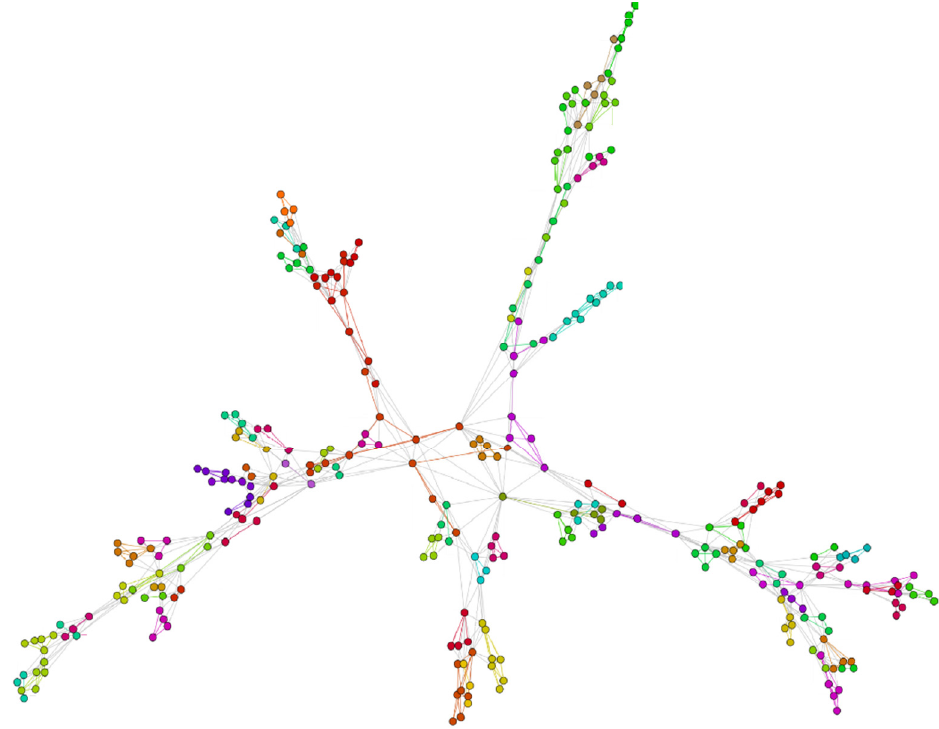
Figure 1. The TMFG filtration with